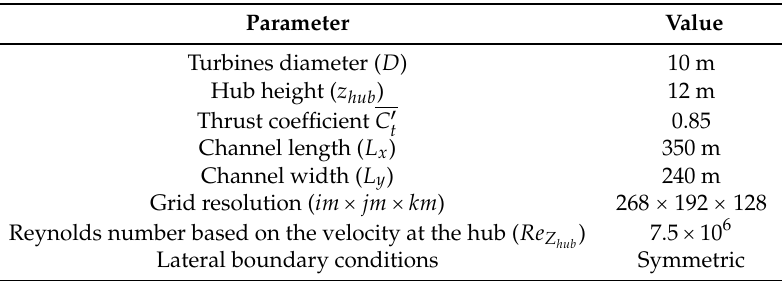
Table 2. Main variables common for all the simulated